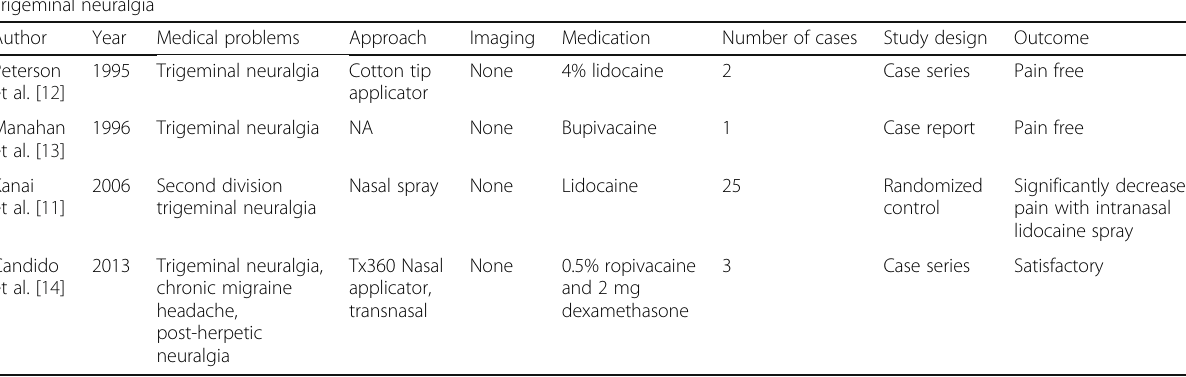
Table 4 Studies of SPG block for trigeminal neuralgia Trigeminal